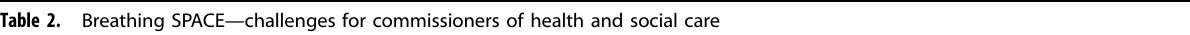
Table 2. Breathing SPACE — challenges for commissioners of health and social care Invest in a population-based approach, describing aims, objectives, and criteria to evaluate the impact of a breathlessness system. Adapt and develop local provision to reduce waste and increase value: know your neighbourhood and local services (tobacco dependence, obesity and physical activity services will vary considerably in the United Kingdom and